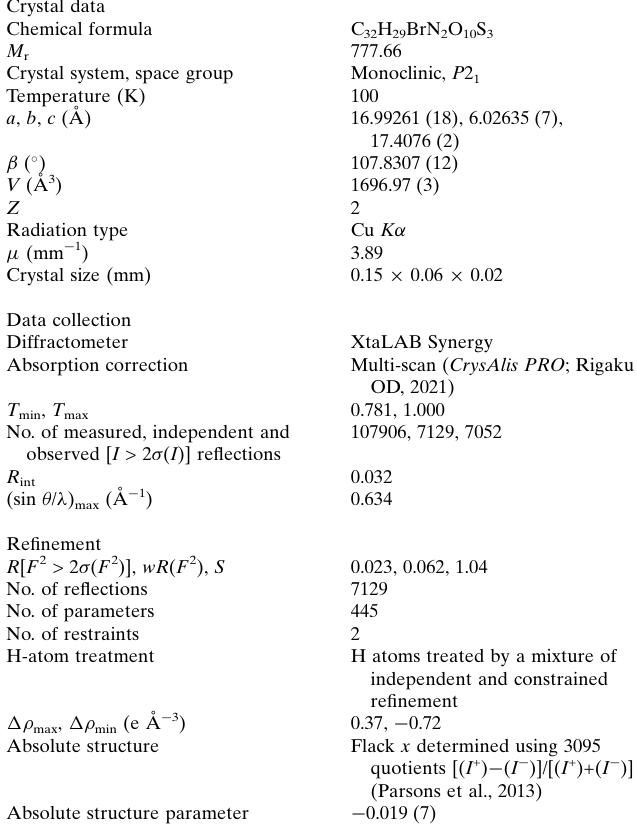
Table 3 Experimental details. Crystal data Chemical formula